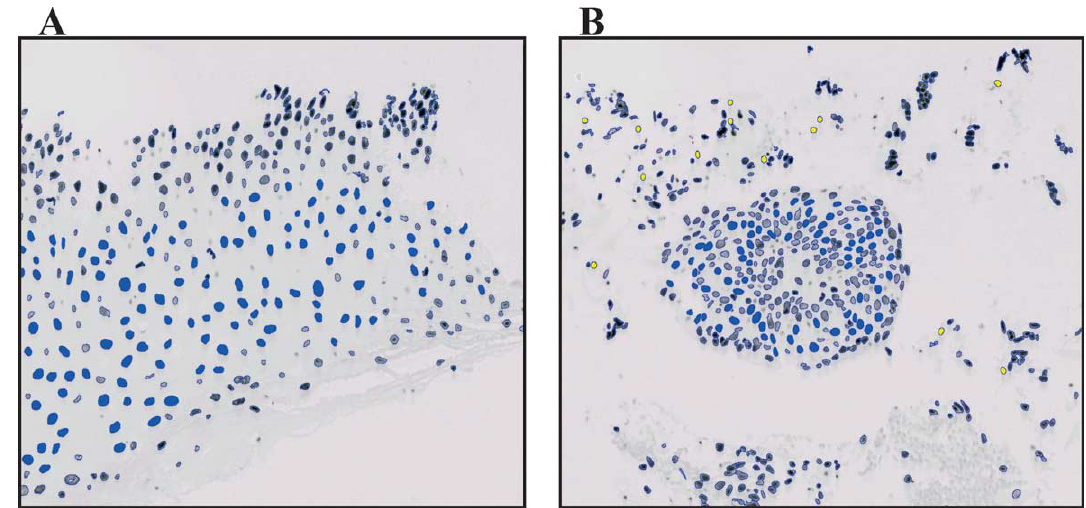
Fig. 4. Examples of different cervical sections. A: The superficial membrane is difficult to recognise and it is impossible to locate any lympho- cytes. B: The stroma compartment is absent: few leukocytes are present (yellow) and the structure of the epithelium is completely lost, making impossible the architectural